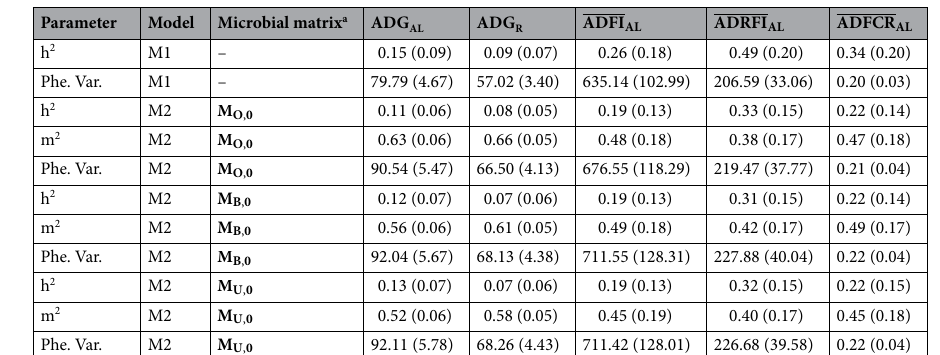
Table 2. Means (SD) of marginal posterior distributions of the heritability (h 2 ), microbiability (m 2 ) and phenotypic variance (Phe. Var.) for individual traits (ADG AL and ADG R ) and cage-average traits ( ADFI AL , ADRFI AL and ADFCRI AL ) obtained with the fullDataset by expanding the corresponding microbial relationship matrix with ones in the diagonal and zeros outside. ADG AL , average daily gain in rabbits fed ad libitum; ADG R , average daily gain in rabbits fed under restriction; ADFI AL , average daily feed intake in rabbits fed ad libitum; ADRFI AL , average daily residual feed intake in rabbits fed ad libitum; ADFCR AL , average daily feed conversion ratio in rabbits fed ad libitum; SD, standard deviation; M1, model without microbial effects; M2, model fitting the microbial effects. a The expansion of the microbial relationship matrix ( M O , M B or M U ) was done by including ones in the diagonal and zeros outside the diagonal for the animals without microbial information.